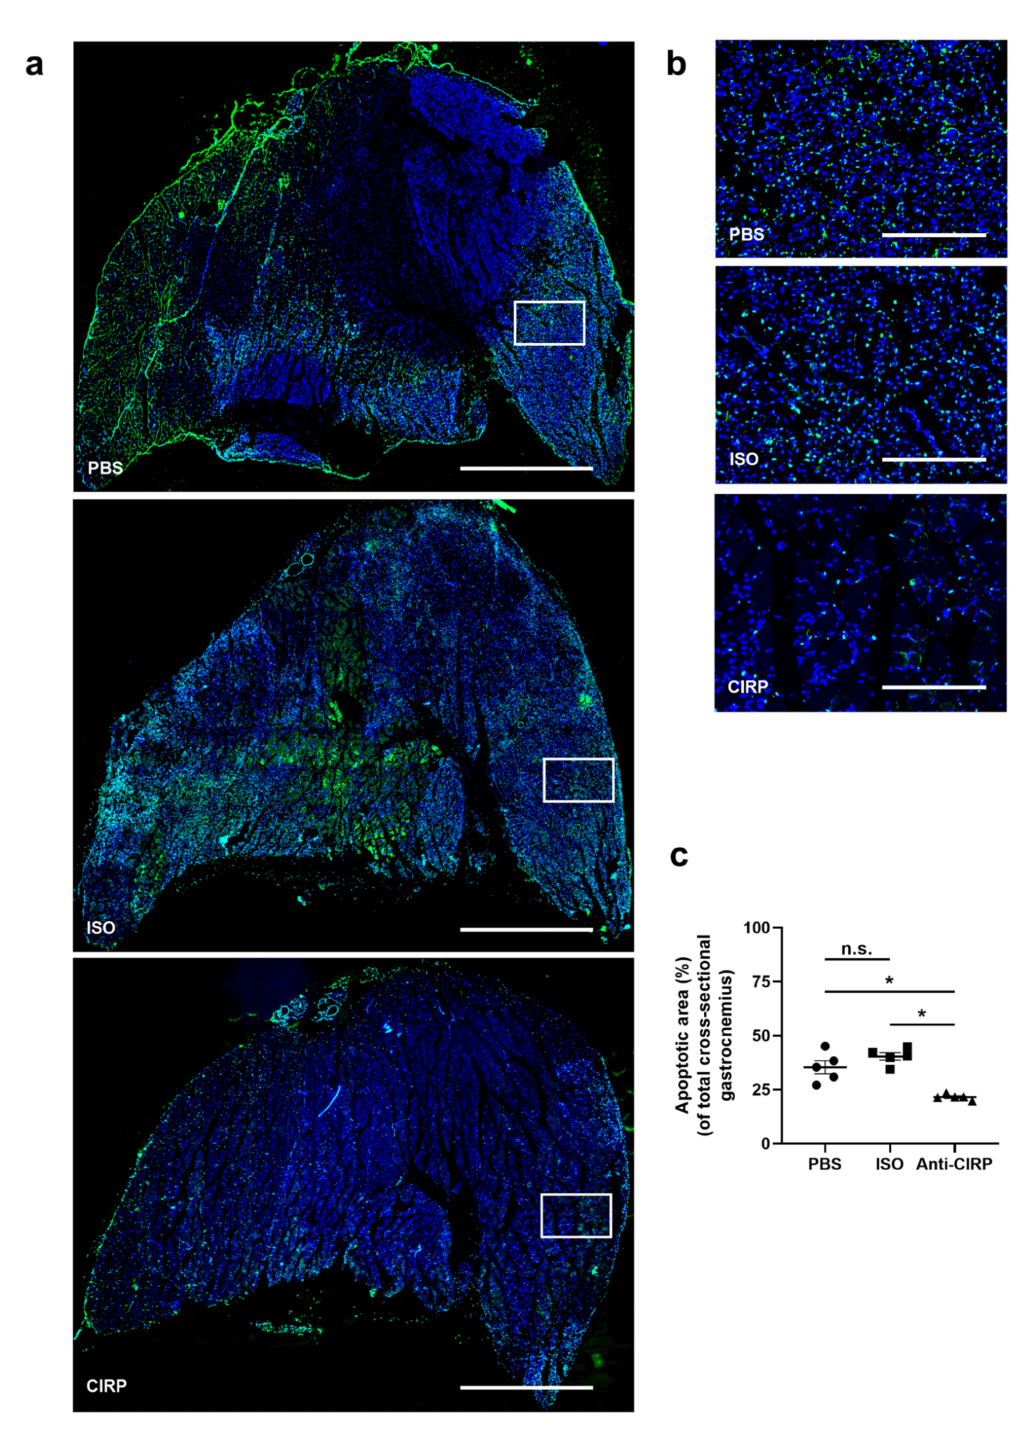
Figure 4. Depletion of extracellular “Cold-inducible RNA-binding protein” (eCIRP) mitigates apoptosis. ( a ) Representative pictures of TUNEL-stained gastrocnemius muscle slices of mice, treated with phosphate-buffered saline (PBS) (top), isotype antibody (ISO) (middle) (both control groups), and anti-CIRP antibody (Anti-CIRP) (bottom) 7 days after femoral artery ligation (FAL). Scale bars represent 50 µ m. ( b ) Magnification of white boxes in ( a ), showing TUNEL-stained apoptotic cells (green). Scale bars represent 7 µ m. ( c ) The scatter plot displays the extent of the apoptotic areas in relation to the whole gastrocnemius muscle of PBS-, ISO-, and anti-CIRP antibody-treated mice 7 days after FAL. The total gastrocnemius cross-sectional area (about 20 mm 2 ) was analyzed. Data are means ± S.E.M., n = 5 per group. n.s. p > 0.05, * p < 0.05 (PBS vs. ISO vs. Anti-CIRP) by one-way ANOVA with the Tukey’s multiple comparisons